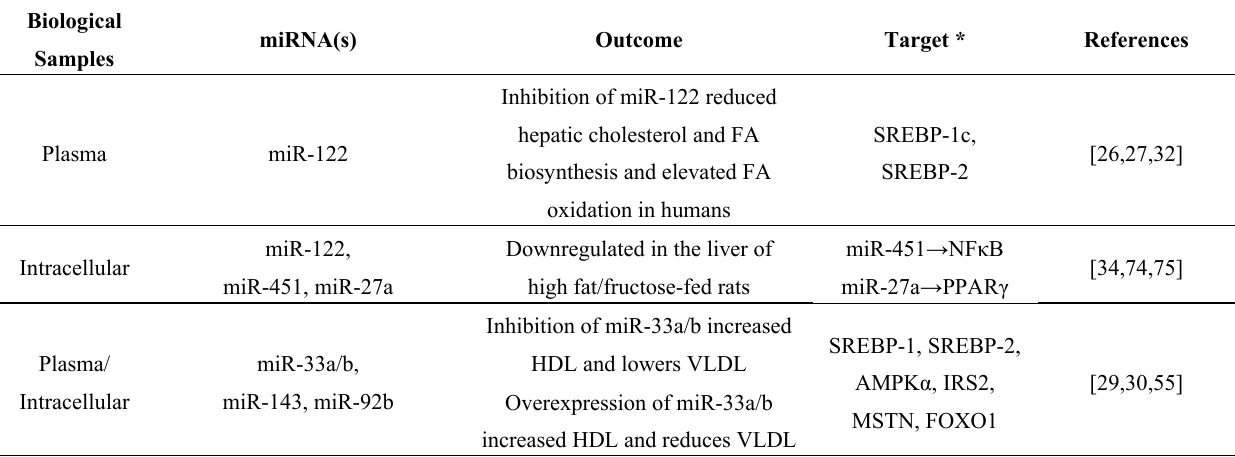
Table 1. List of miRNAs involved in different biological processes of hepatic lipid